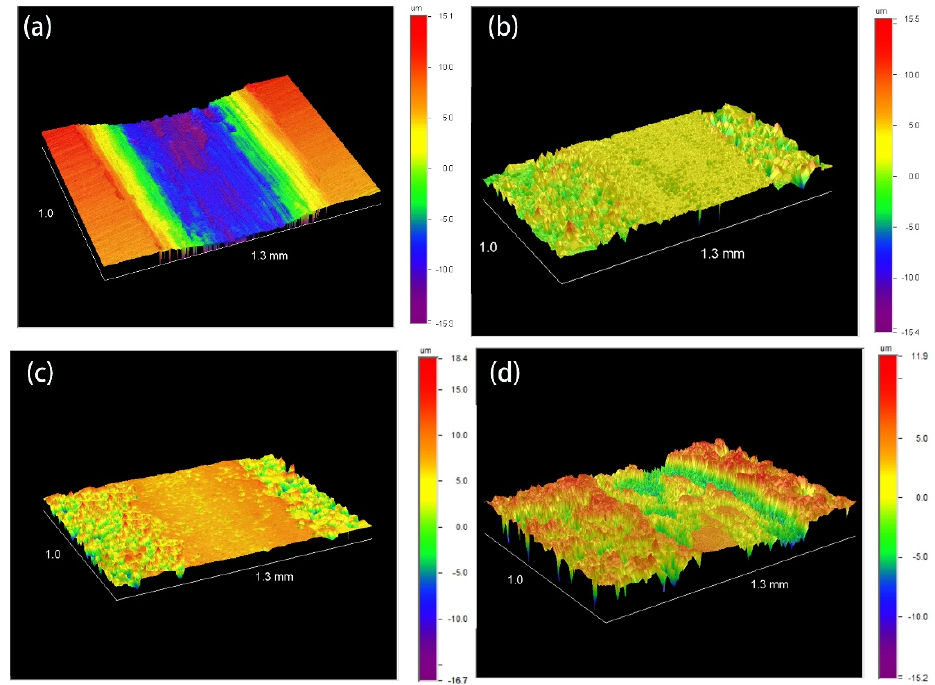
Figure 8. Profilometer images of wear tracks after 30 min of wear under 4 N: ( a ) Al-Zn-Mg-Cu alloy, ( b ) coating A, ( c ) coating B and ( d ) coating C.